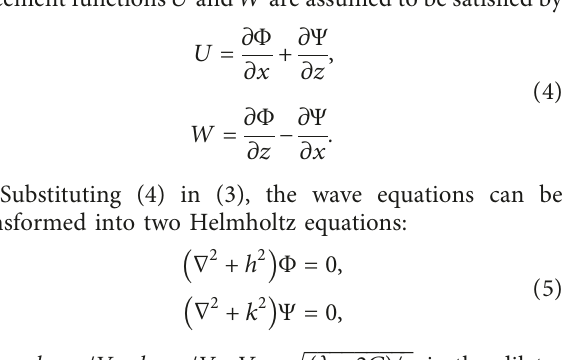
2 z 2 / z x 2 z 2 / z z 2 denote the volumetric strain (cid:31) (( ) + ( )) and the Laplacian operator, respectively. ∇